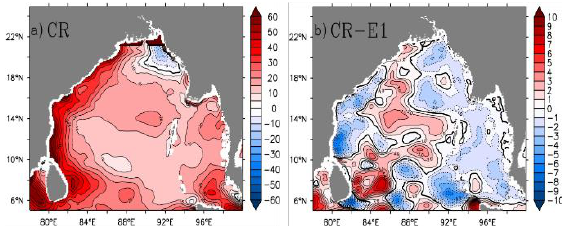
Figure 2. Time-mean Heat flux (Watt/m2) of (a) CR and the time-mean differences between (b) CR and E1 for the year